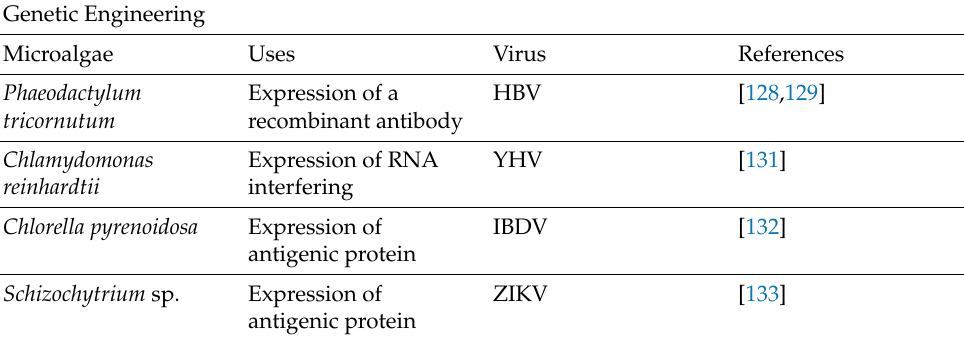
Table 5. Genetic